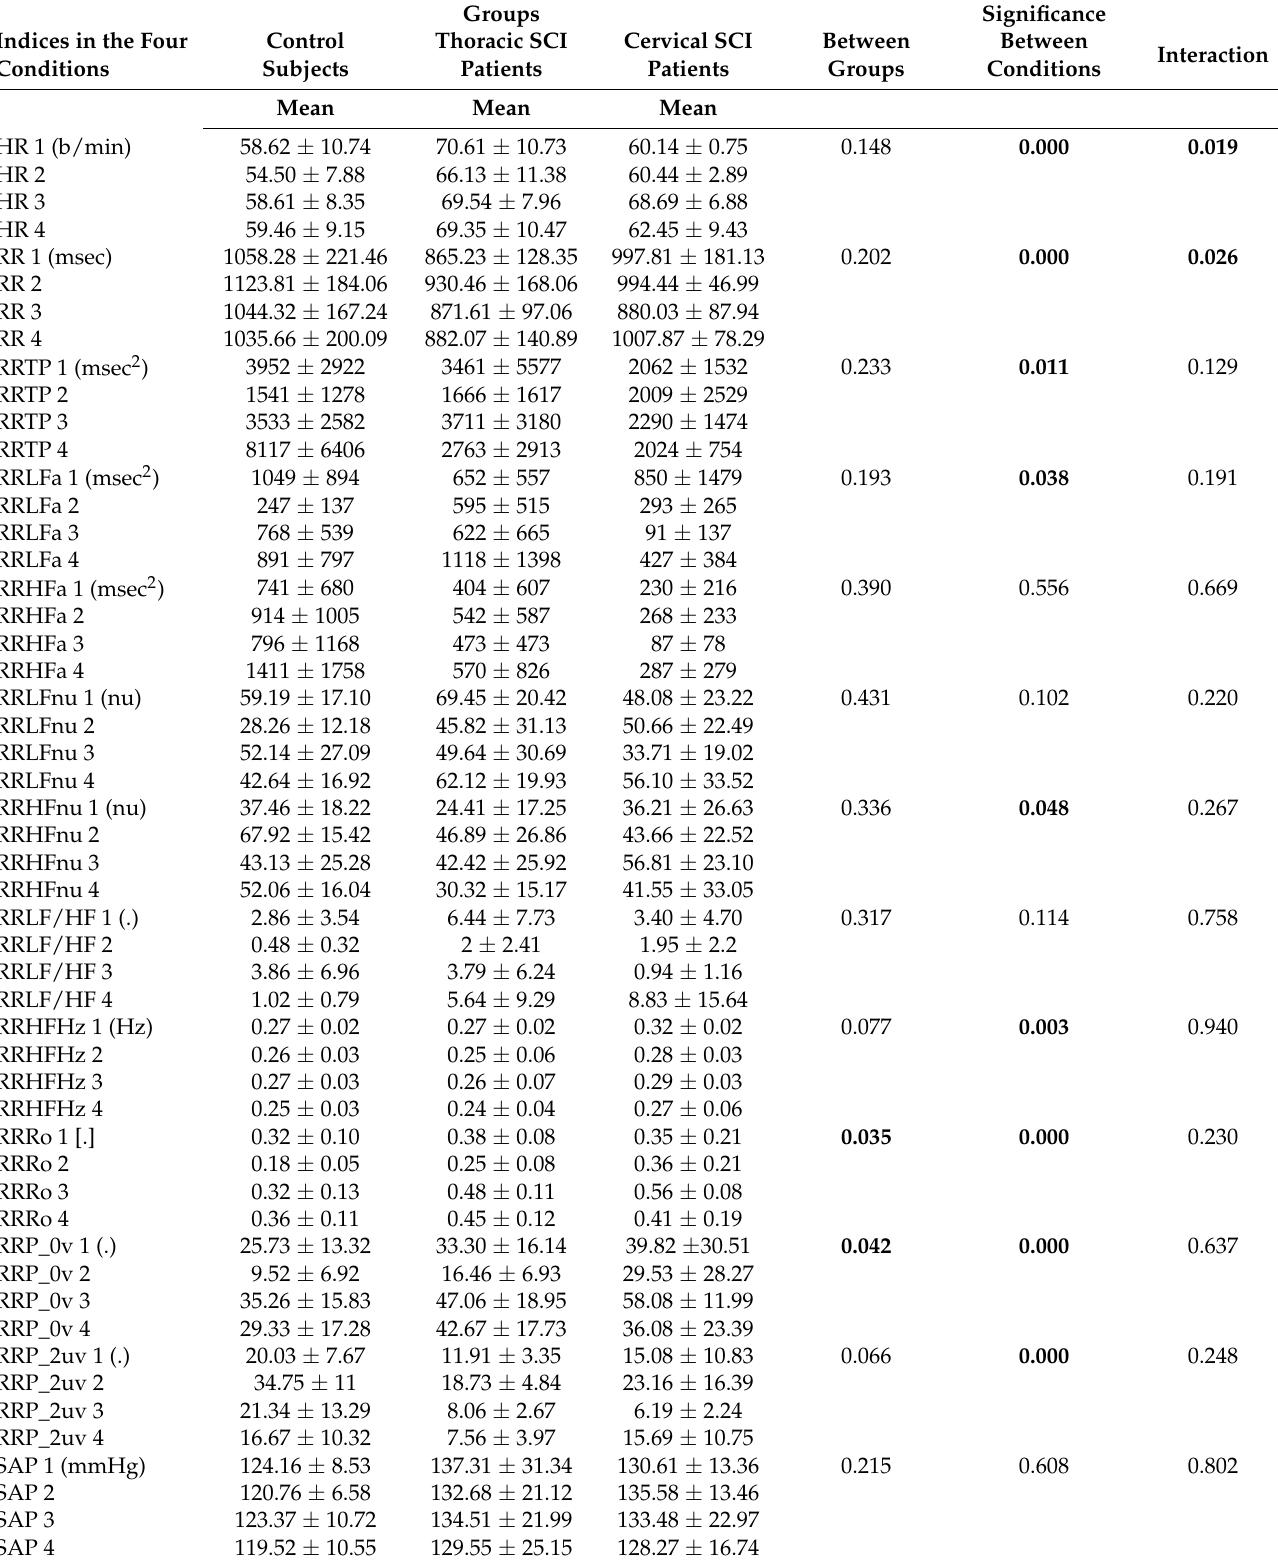
Table 1. Summary descriptive data of the three study groups during the four conditions considered during polysomnographic